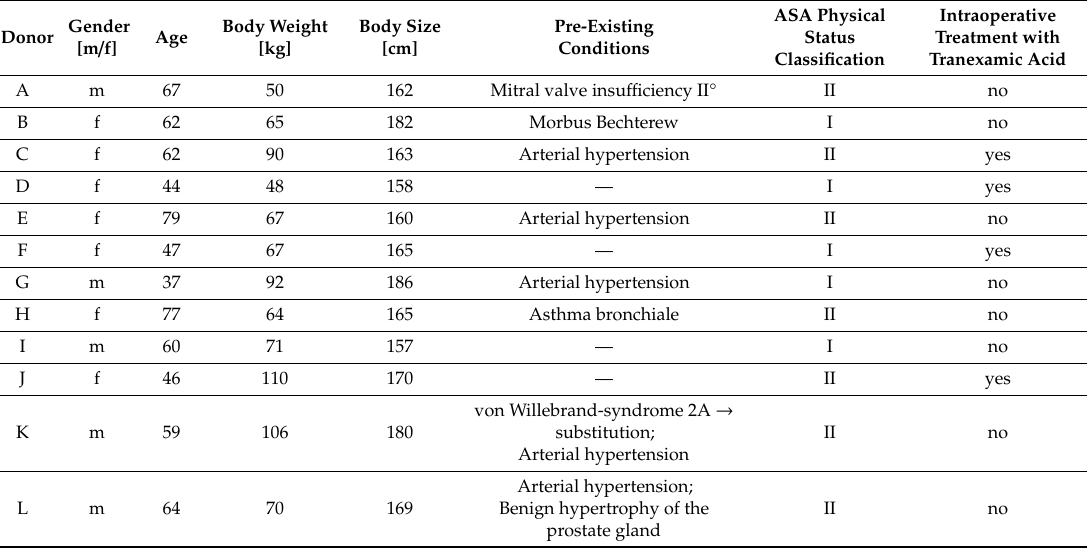
Table 1. Information of bone marrow donors and passages of cells used in the analyses.